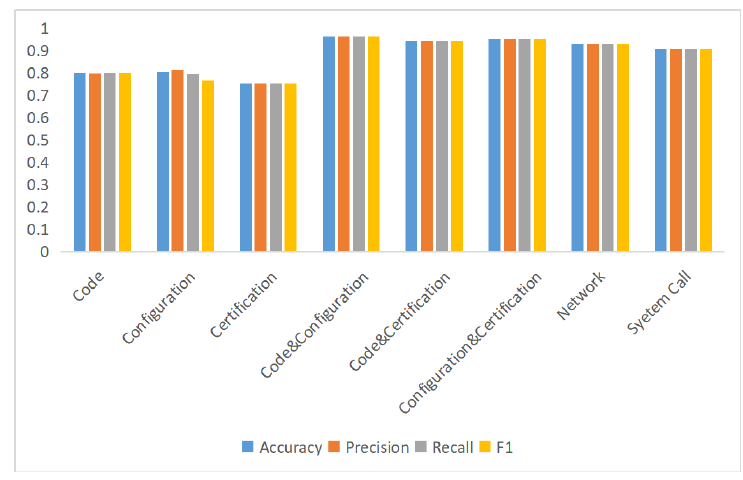
Figure 10. Performance of each dimension and dimension combination.